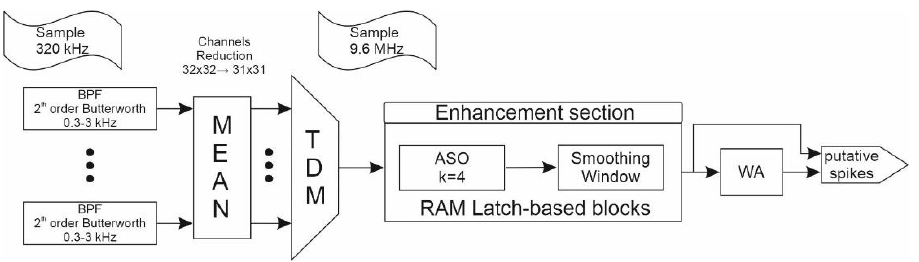
Figure 5. Hardware pipeline